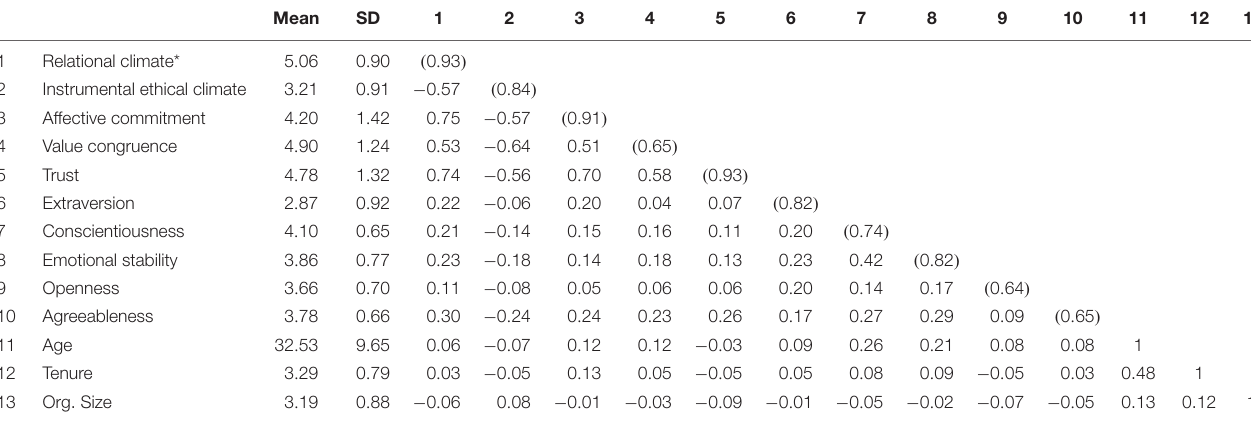
TABLE 11 | Correlation matrix for Study 4—consequences 1 ( N = 354).